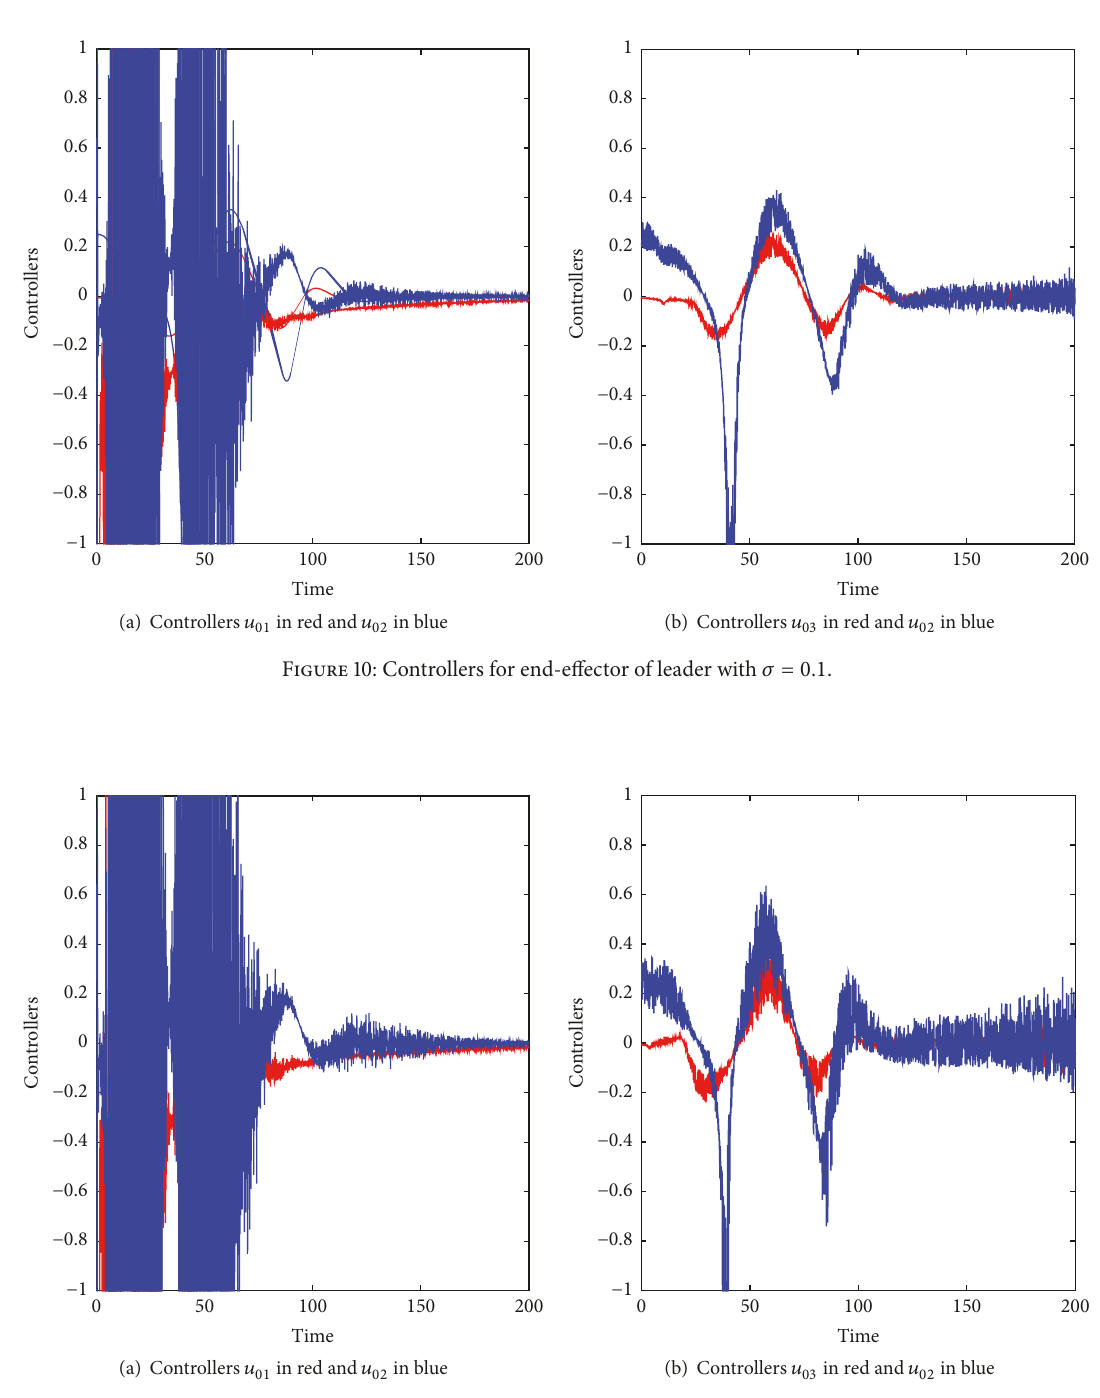
Figure 11: Controllers for end-effector of leader with 𝜎 = 0.2